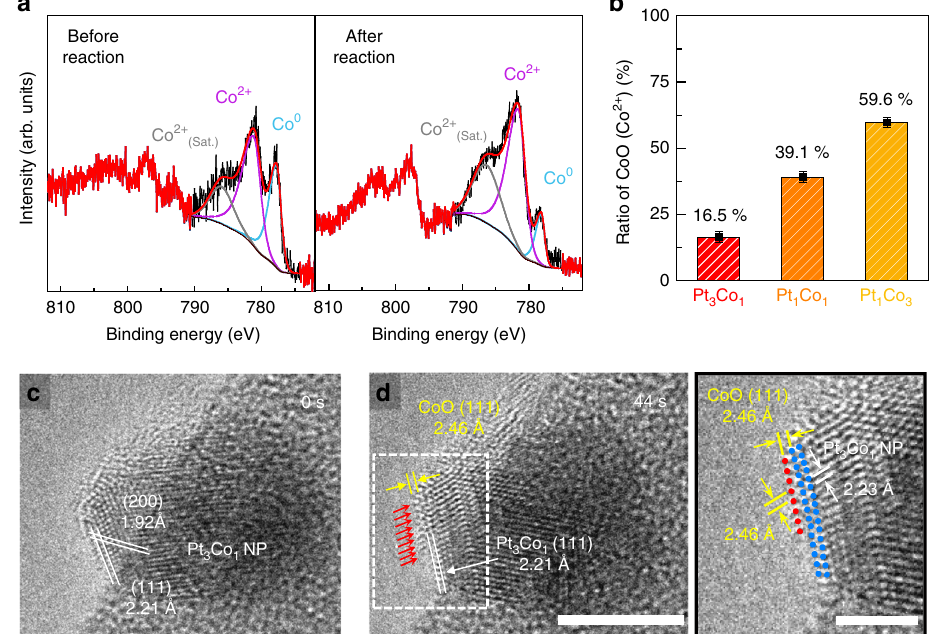
Fig. 4 Formation of CoO on PtCo bimetallic NPs. a Co 2p XPS spectra showing the oxidation states of the Co in the Pt x Co y bimetallic NPs before and after H 2 oxidation. b Relative ratio of CoO in the Pt x Co y bimetallic NPs estimated using the peak area of Co 2 + . Error bars are ± sd. Sequential in situ TEM images of the Pt 3 Co 1 NP taken at c 0 and d 36 s during oxidization at 125 °C in 0.5 mbar of O 2 gas. As denoted by the red arrows, additional Co atoms segregated on the Pt 3 Co 1 NP surface. The difference in lattice spacing between the top-most layer and the inner portion is clearly shown in the enlargement region denoted by the white rectangle. Scale bars are 5 nm (left) and 2 nm